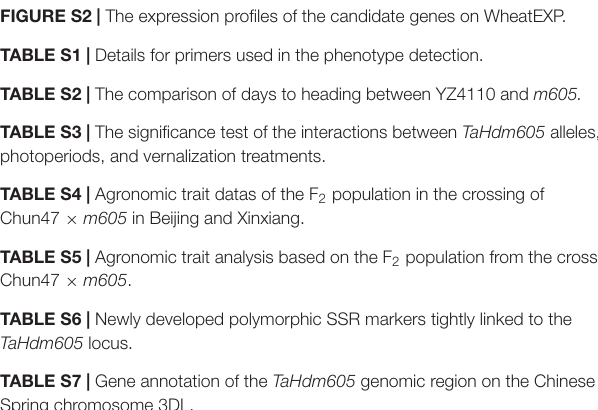
FIGURE S1 | Comparision of floral primordium betweenYZ4110 and m605 . (A,C) Floral primordium of YZ4110. (B,D) Floral primordium of m605. FIGURE S2 | The expression profiles of the candidate genes on WheatEXP. TABLE S1 | Details for primers used in the phenotype detection. TABLE S2 | The comparison of days to heading between YZ4110 and